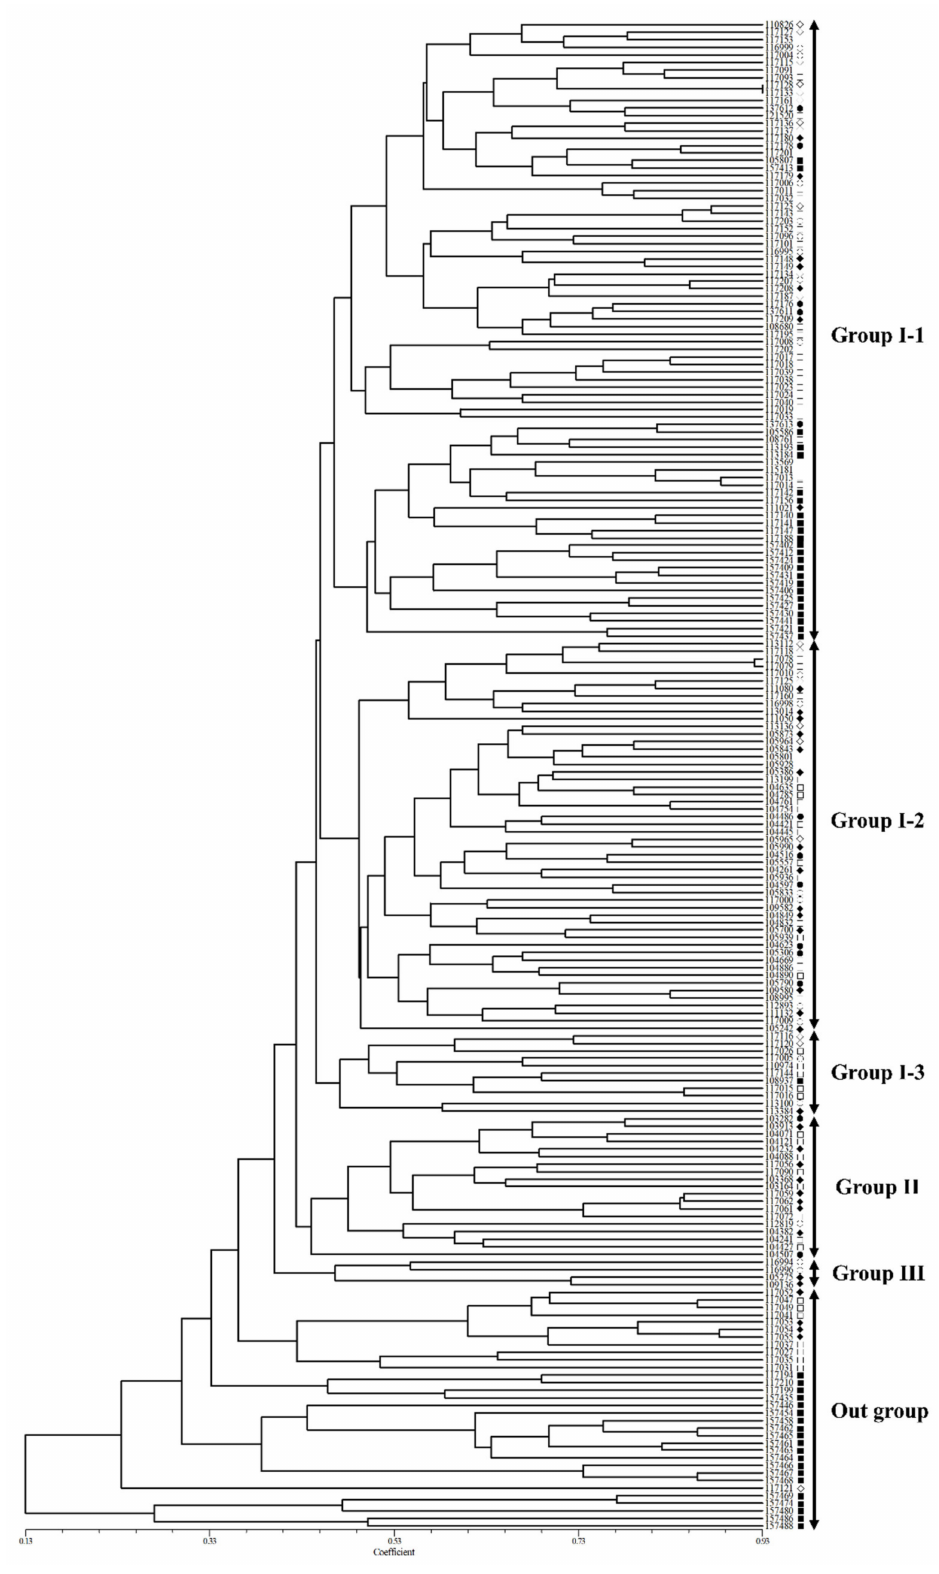
Figure 4. UPGMA dendrogram of 200 accessions of the native Perilla frutescens var. frutescens based on 20 SSR markers. The solid line represents the 11 major groups. (cid:35) Gyongsang-do, (cid:4) : other